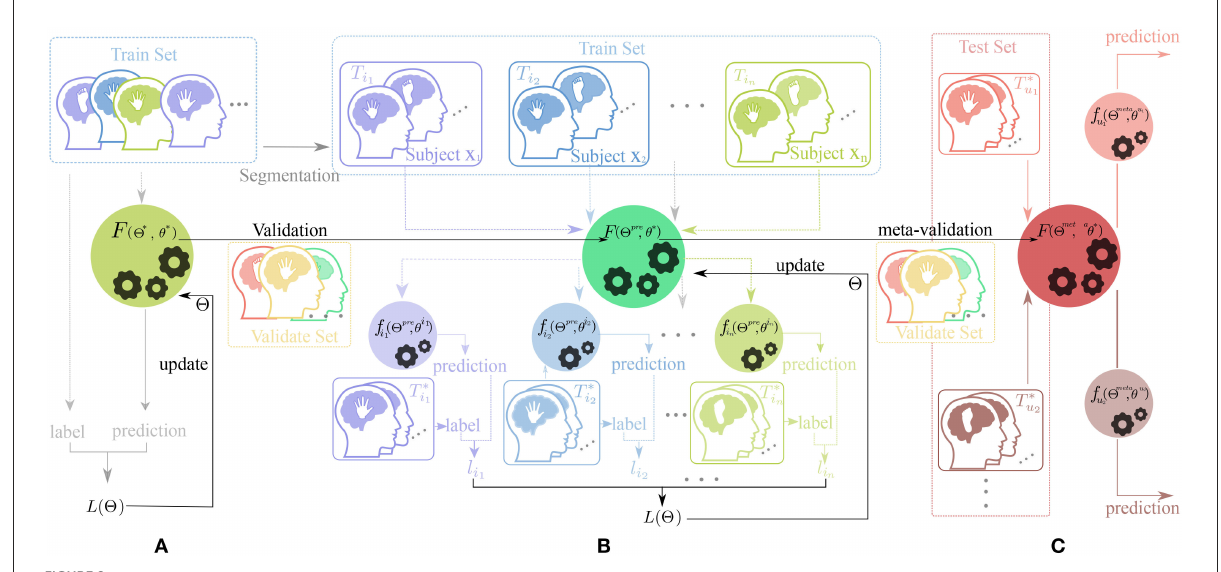
FIGURE2 Workflow of our training framework. The dataset for training, validation, and test process is displayed on different rectangular regions with the colors blue, yellow, and red, respectfully. The picture of human heads in different colors (such as purple, blue, yellow, brown, and red) with a hand or feet inside represent the data from different subjects doing motor-imagery tasks. The black horizontal lines with a black arrow represent the change of the parameter of the neural network and the colorful vertical and horizontal lines (such as purple, blue, gray, and green) indicate the direction of data flow. In addition, the black gears in the circle represent the update process of parameters. (A) Pre-train phase, (B) Meta-update phase, and (C) Domain-adaption phase.